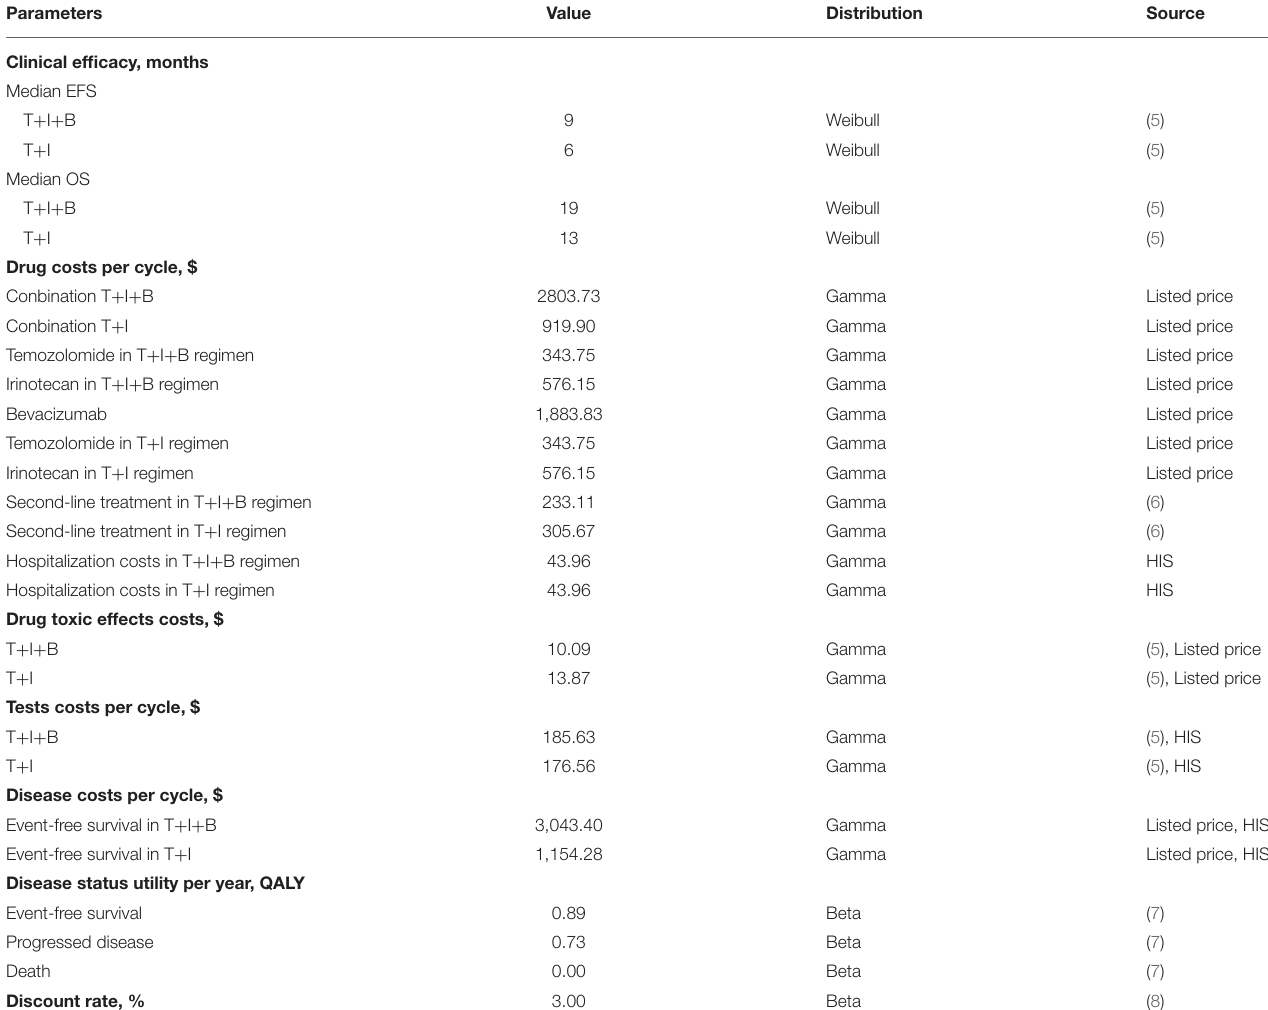
TABLE 1 | Parameters for the base case cost-effectiveness